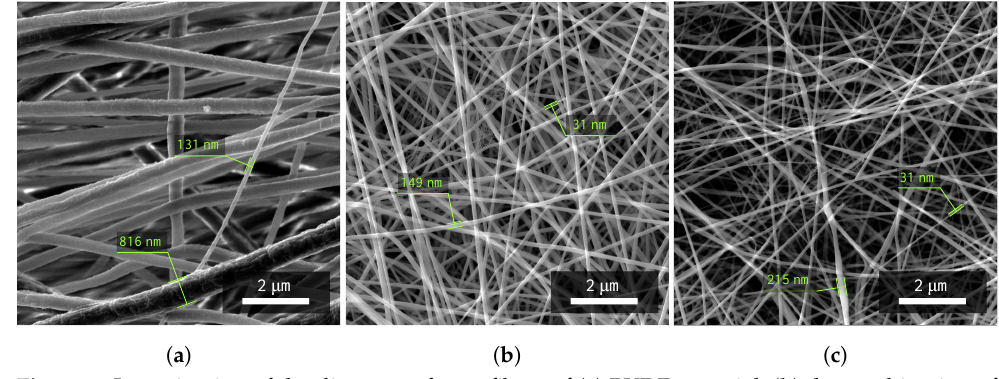
Figure 1. Investigation of the diameter of nanofibers of ( a ) PVDF material, ( b ) the combination of PVDF/PA6, and ( c ) PA6. Fibers of different sizes were randomly selected. Measurement parameters: acceleration voltage 5kV, magnification 27.7k × .